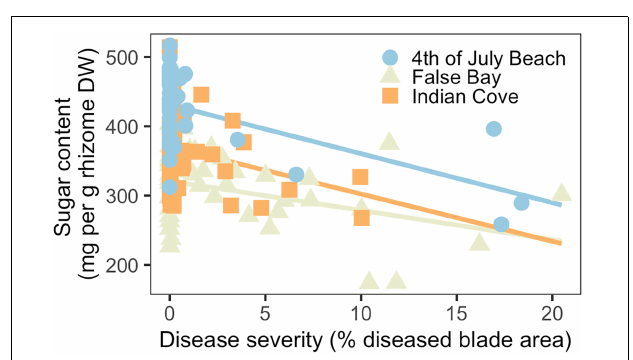
FIGURE 4 | Rhizome sugar content declined as a function of disease severity ( n = 135) at three eelgrass